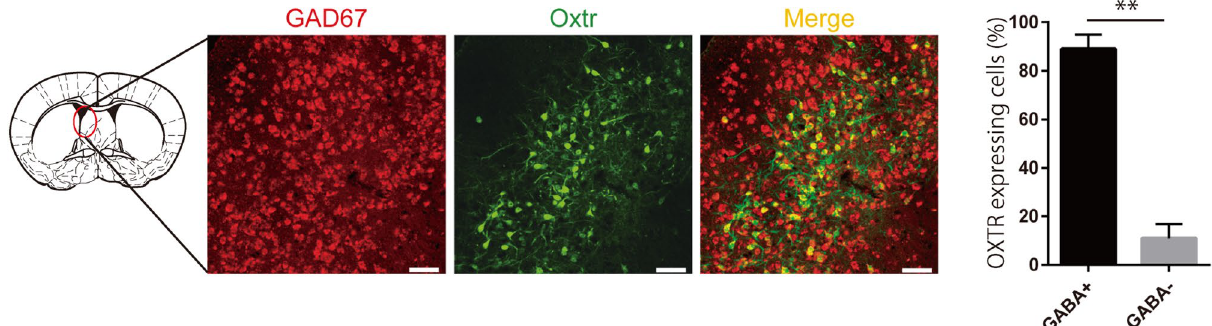
Figure 4. Oxytocin receptor (OXTR)-expressing neurons in the lateral septum (LS) were GABAergic neurons. Confocal images of the LS show neurons expressing mRNAs for GAD67 and OXTR in Oxtr-Venus mice (left). The ratio of the number of OXTR+ neurons of GABA (+) cells and GABA (−) cells in the LS is shown(N = 3) (right). Unpaired t-tests were performed for the graph. ** p < 0.01. The brain illustration is an adaption as well as Figs. 1C and